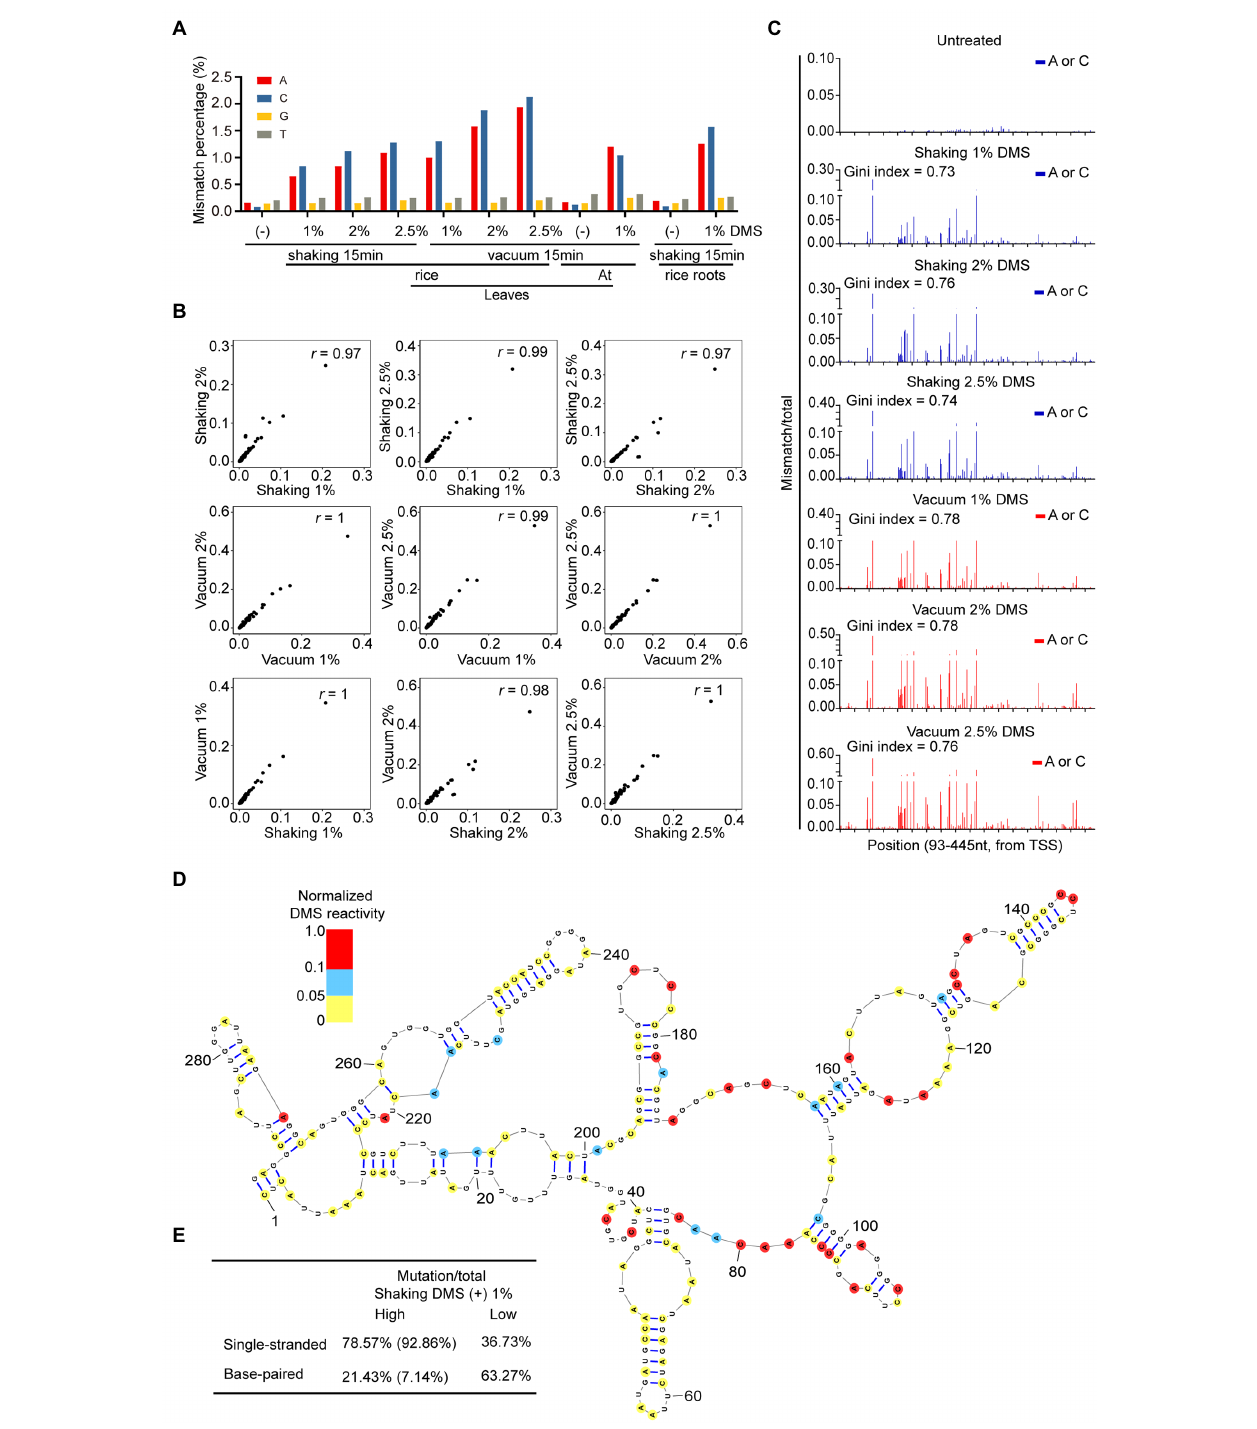
FIGURE 3 | High-quality of target-specific DMS-MaPseq data in rice. (A) Total mismatch percentage on each nucleotide in untreated and DMS-treated 18S rRNA region (93-445nt). (B) High correlation of DMS-MaPseq signal for A and C nucleotides in tested 18S rRNA (93–445 nt) region under varying DMS concentrations and incubation conditions. Pearson’s r values are shown. The data in X -axis and Y -axis were mismatch/total mutation rate in corresponding DMS treatment conditions. (C) Ratiometric DMS signals of each A and C were plotted along 18S rRNA sequence. Similar Gini index values indicated the high similarity in distribution pattern of DMS mutation signals in different DMS-treated samples. TSS, Transcriptional start site. (D) Nucleotides 98–390 of the phylogenetic rice 18S rRNA structure was color-coded according to the DMS mutation signal from DMS-MaPseq. (E) High correlation between DMS mutation signal and 18S rRNA phylogenetic